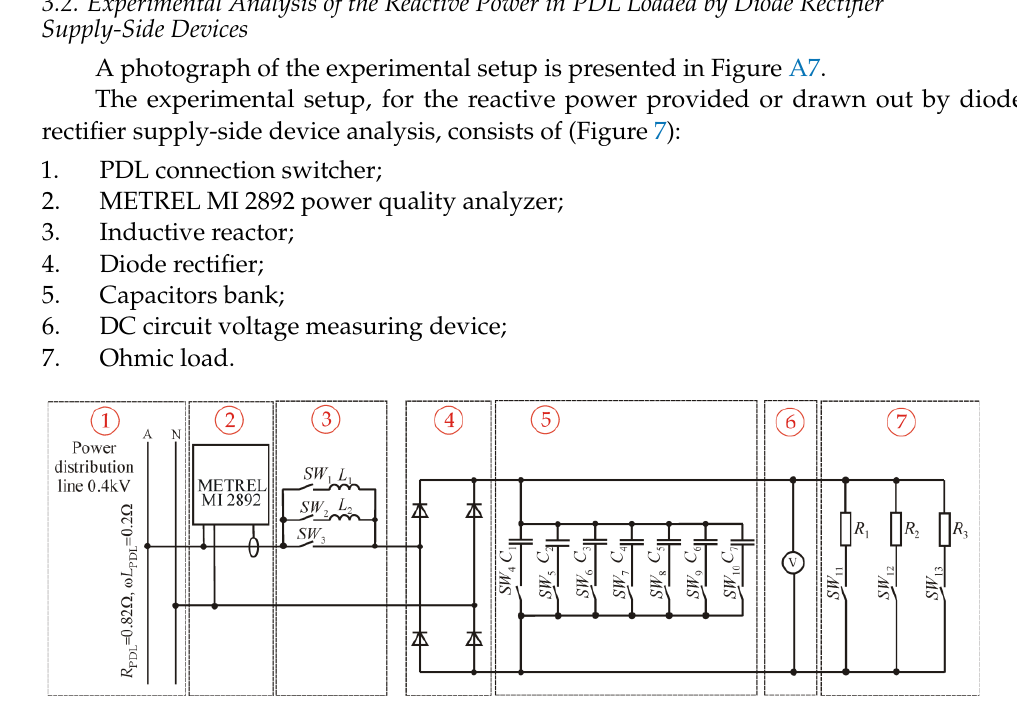
Figure 8. Active and reactive power components at the point of connection of the single-phase diode rectifier supply-side device to the PDL as a function of DC circuit capacity value in case of internal parameters of PDL-connected R = 0.82 Ω, ω L = 0.2 Ω.